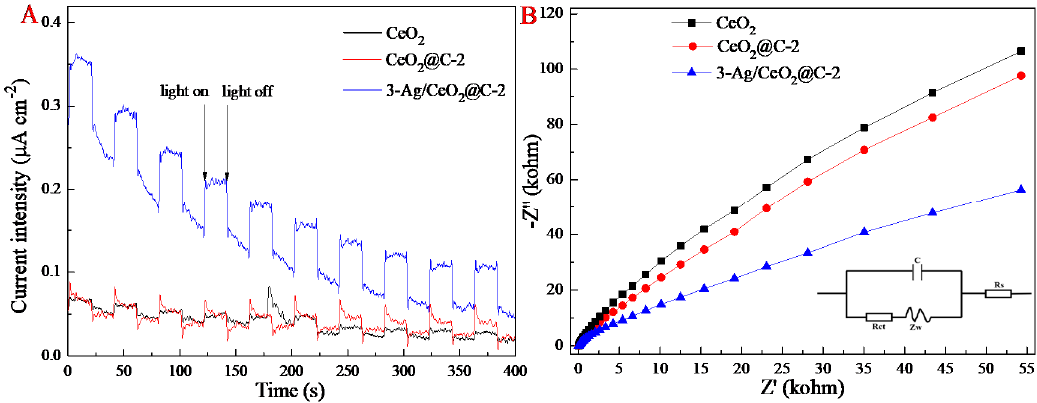
Figure 6. Photocurrent–time response ( A ) and electrochemical impedance spectroscopy (EIS) Nyquist plots ( B ) of 3-Ag/CeO 2 @C-2.